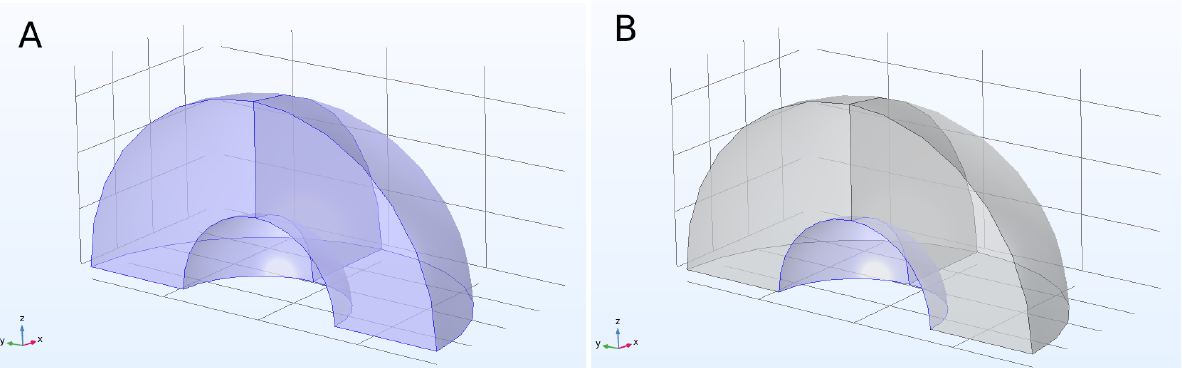
Figure 1. ( A ) A quarter of the PML domain and ( B ) a quarter of the scattering boundary are high-